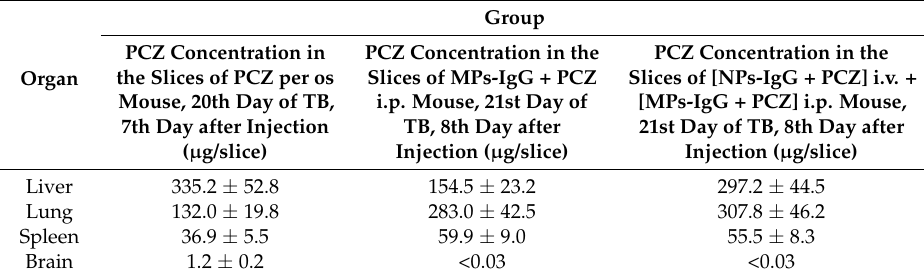
Table 4. Quantitation of perchlozone in the mouse tissues with LC–MS.